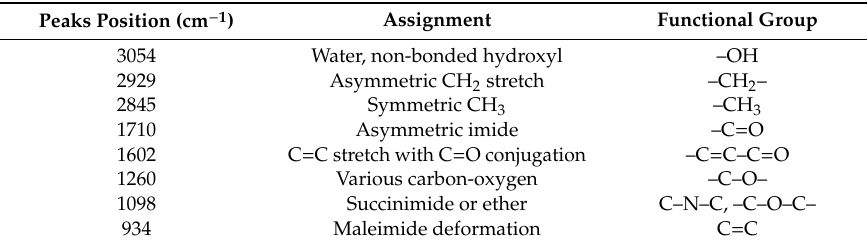
Figure 4. Fourier Transform Infrared (FTIR) spectra of the bismaleimide (BMI) composite aging for different periods. Table 2. FTIR characteristic peaks position of the aged BMI composite [16,28,29].